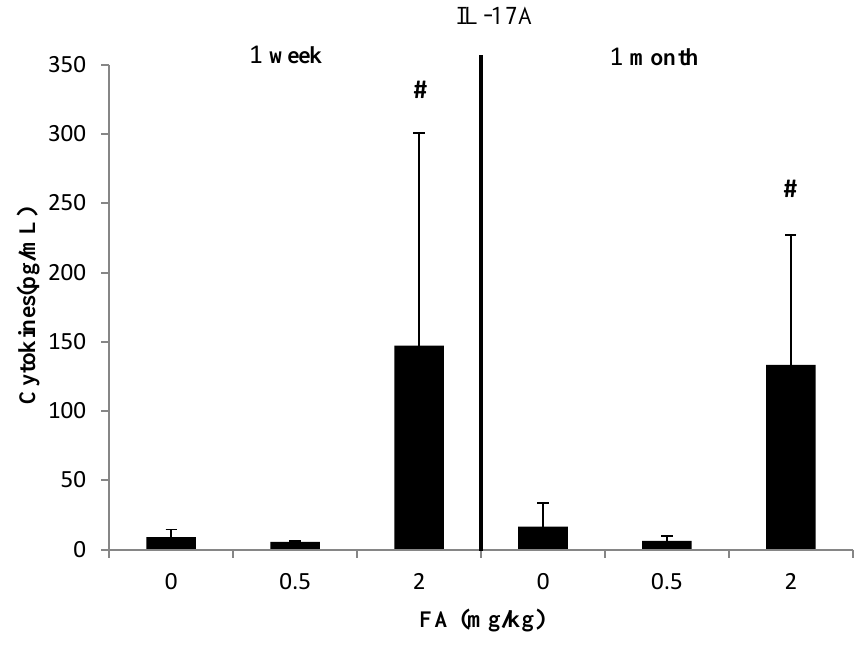
Note: # Significantly different from 0.5 mg/kg FA exposure, p <